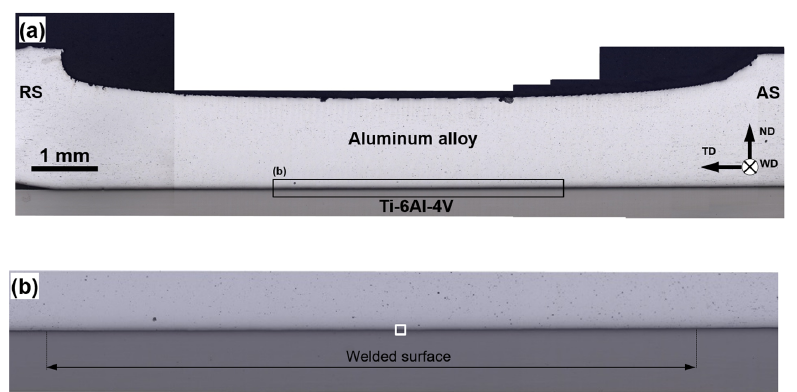
Figure 2. Typical cross-sectional optical image of welded joints (unetched condition): ( a ) low-magnification overview, ( b ) welded surface. ND, TD, and WD are normal direction, transverse direction, and welding direction, respectively. RS and AS are retreating side and advancing side, respectively. Note: the selected area in ( b ) shows the typical position of SEM and EDS observations. Note 2: The optical micrographs were taken from the welded joint of AA6013 alloy produced at a welding speed of 76.2 Table 3. Effect of chemical composition of aluminum alloys and welding speed on cross-sectional width of welded surface.